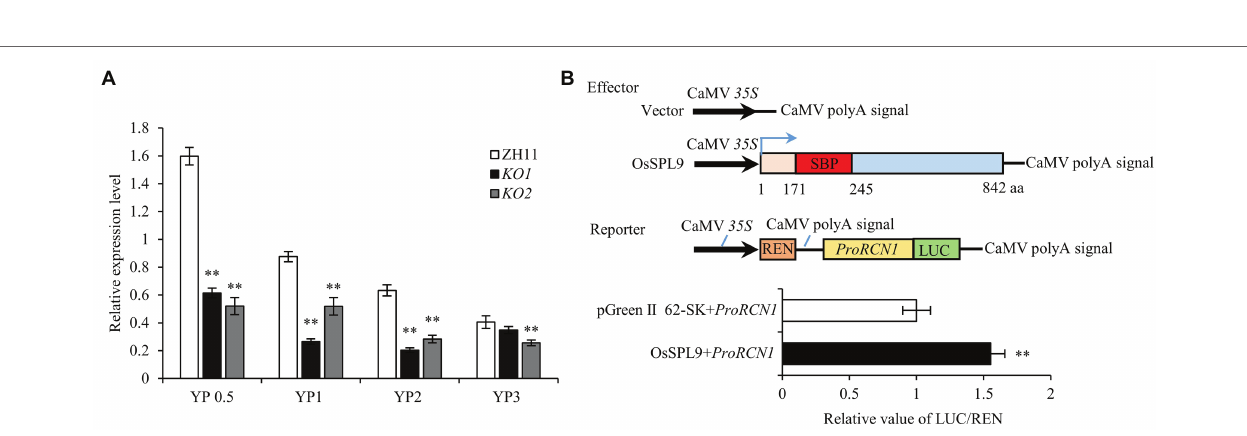
FIGURE 3 | Expression pattern of OsSPL9 . (A) Transcript levels of OsSPL9 in various organs by RT-qPCR. R, young root; S, stem; LB, leaf blade in the tillering stage; LS, leaf sheath; YP1–YP15, young panicles of different lengths (1–15 cm). H9–H15, hulls from panicles with different lengths (9–15 cm). E5–E10, endosperm at 5 and 10 days after fertilization. Data are given as means ± SD of three biological replicates. (B) GUS staining in the ProOsSPL9 ::GUS transgenic plants. Root (I); leaf sheath (II); and early developing young panicle and stem (III). Scale bars: 2 mm (I,II) and 1 cm (III).